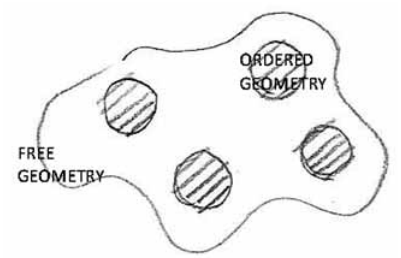
fig. 2b. Site plan of the highlighted part of Mosalla neighborhood ( Ibid ., p. 32)